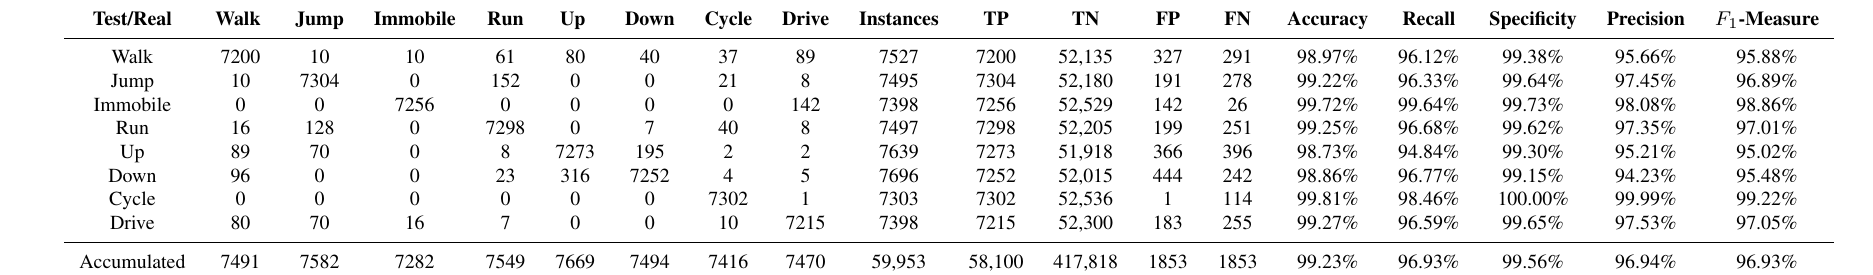
Table B1. Confusion matrix and performance values for the Ameva-based classification system.